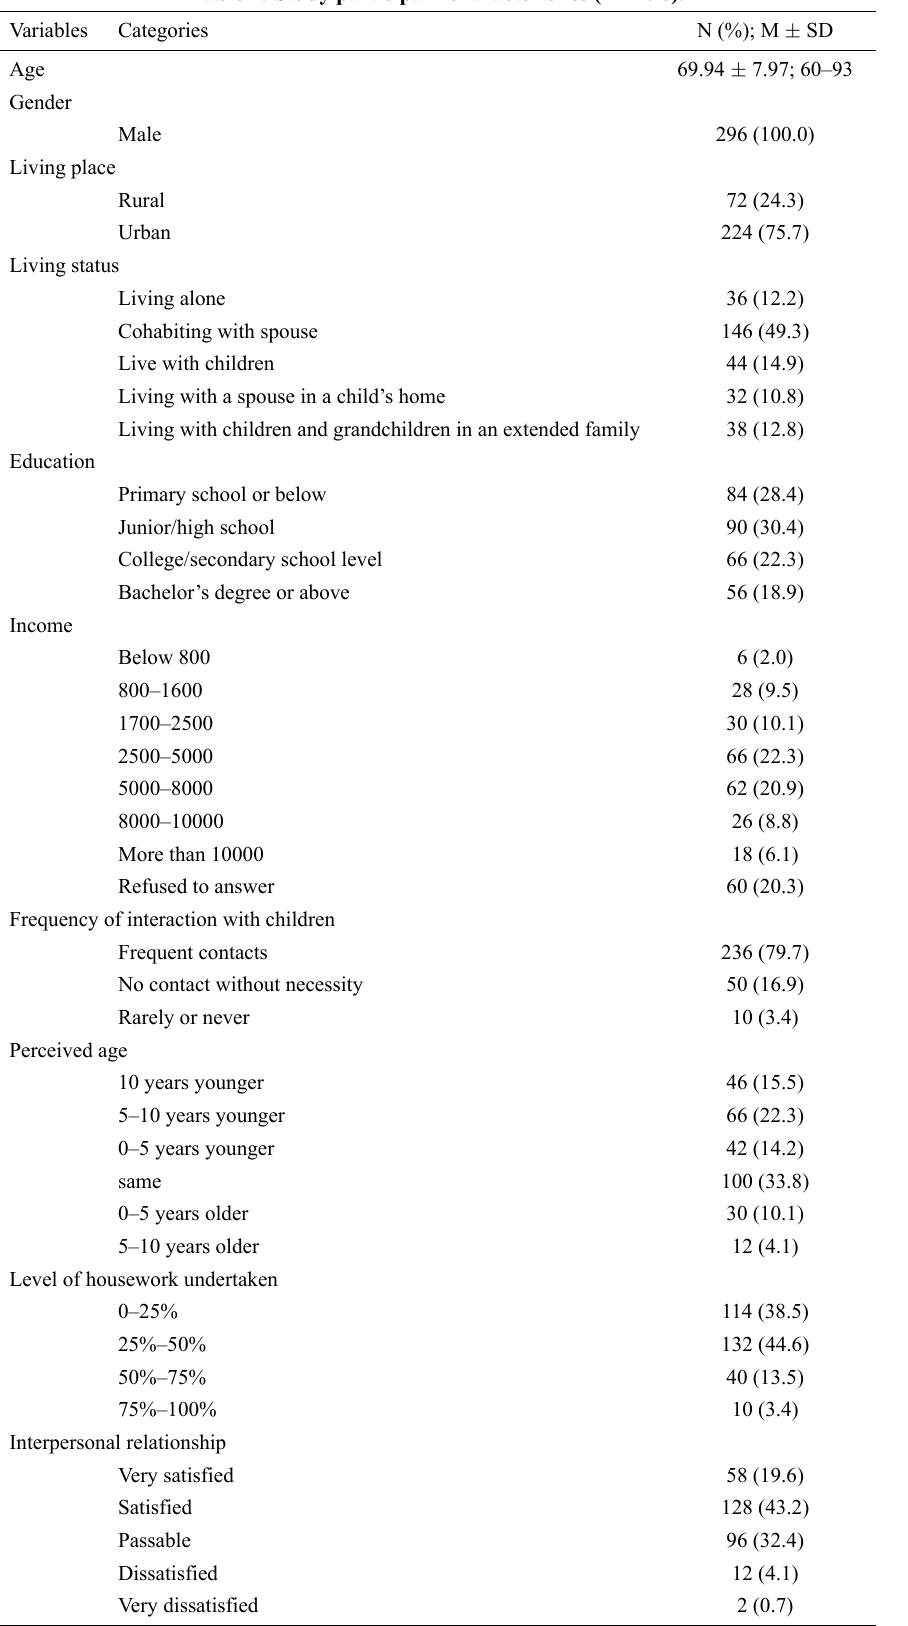
Table 1. Study participant characteristics (n =